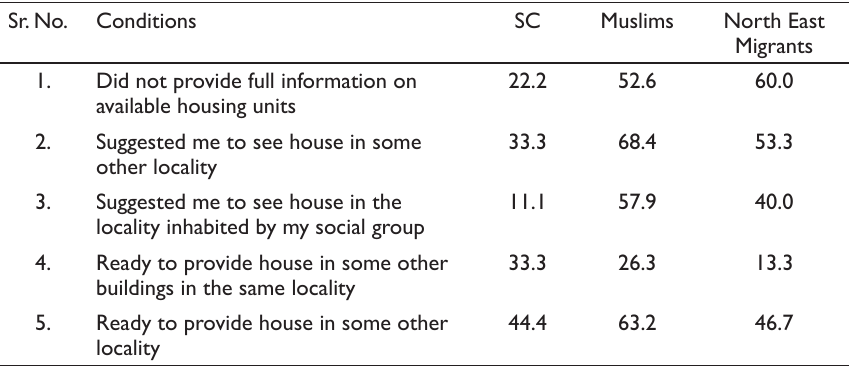
Table 13. Social Steering Away by Brokers Sr.